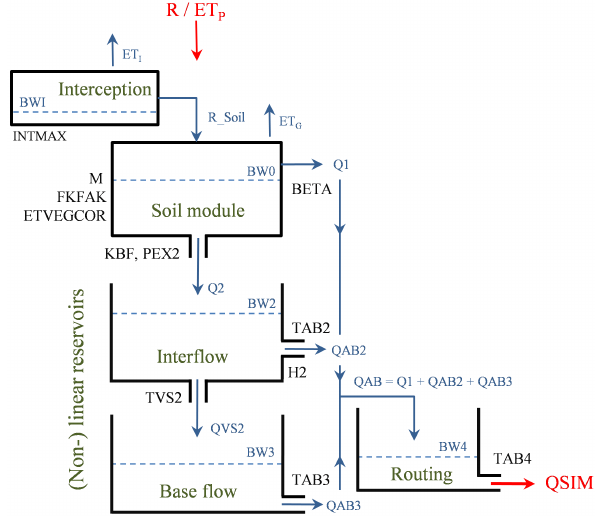
Figure 1. Structure, parameters and states of the forward